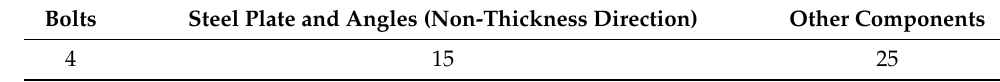
Table 3. Global mesh sizes of members